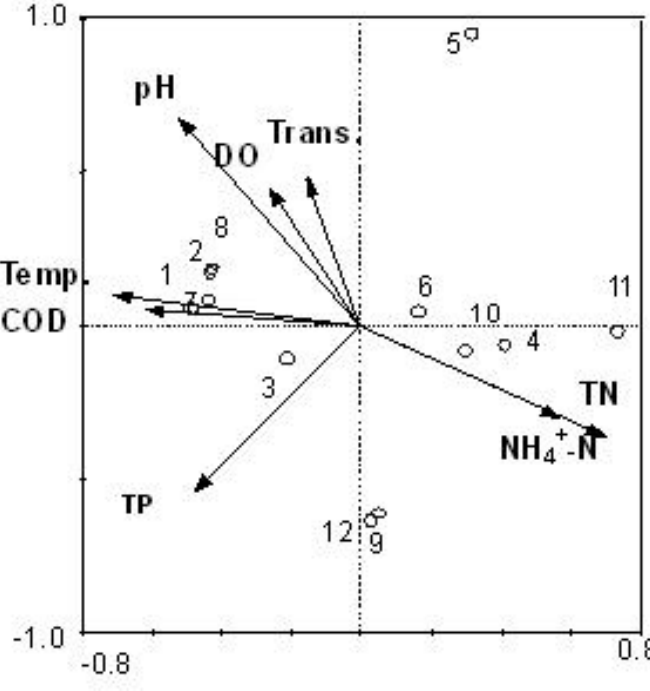
4. Canonical correspondence analysis (CCA) ordination diagram of